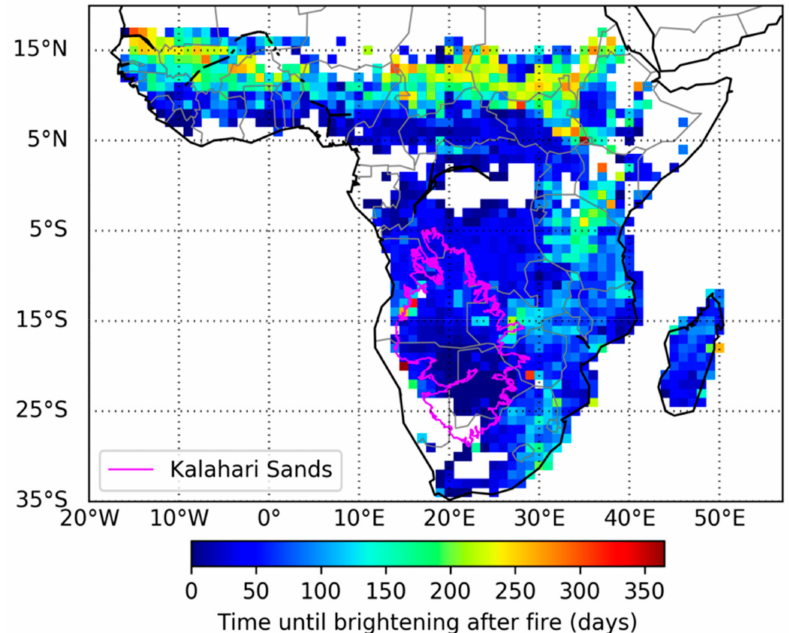
Figure 4. Timing of first brightening following fire. Individual albedo time series are binned as in Figure 3 using a weighted average. The timing for the first observed brightening for these binned averages is depicted here. An outline of the Kalahari Sands is shown in